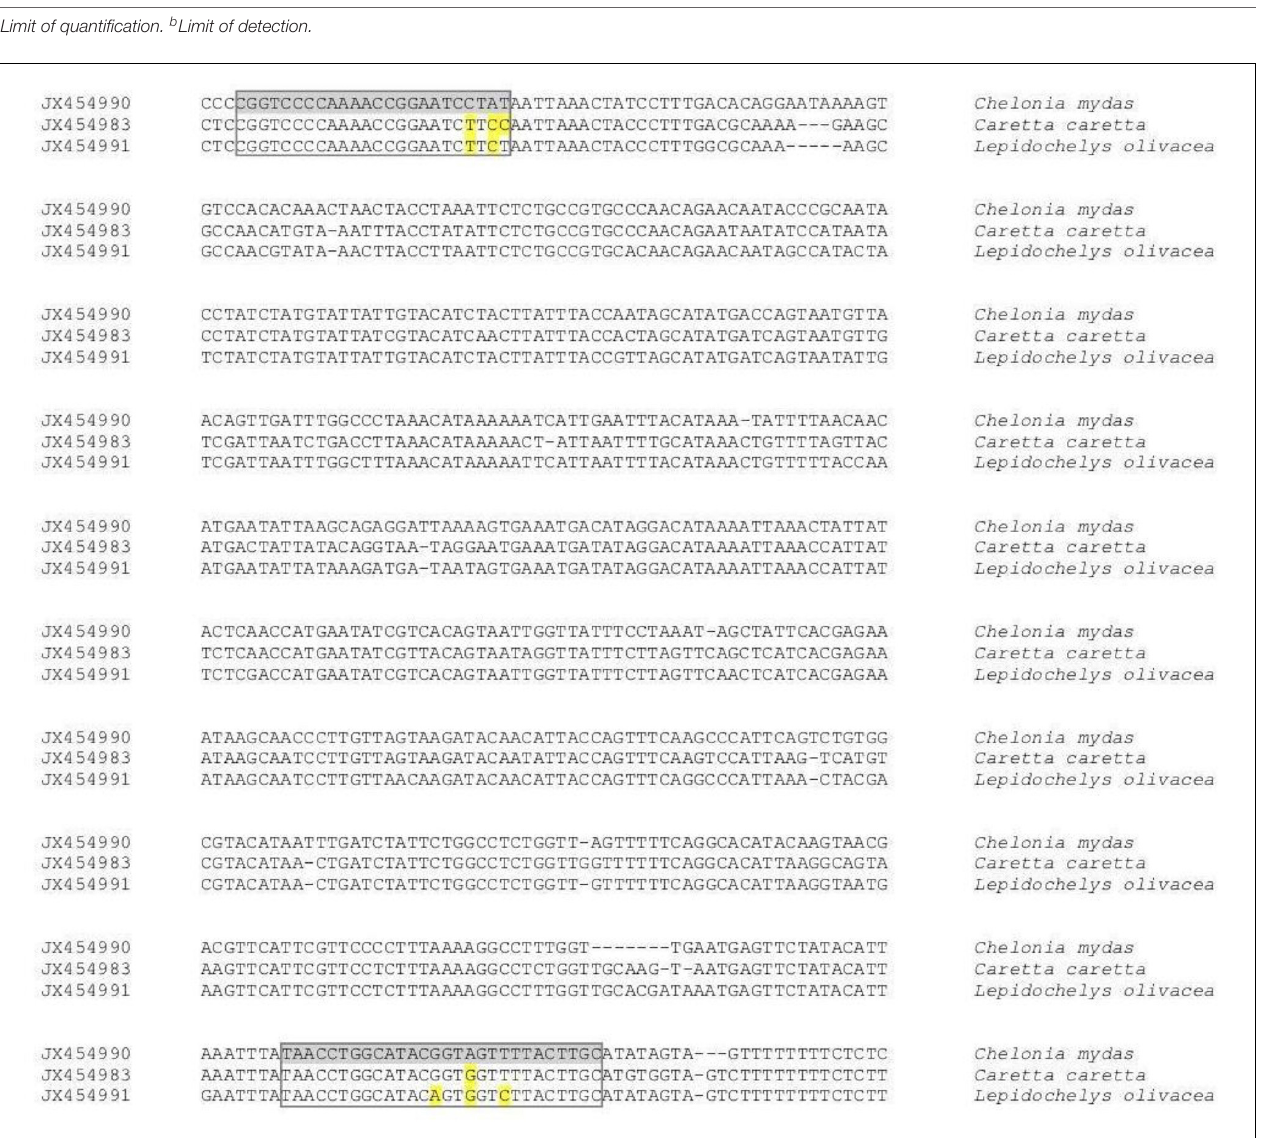
FIGURE 2 | The Chelonia mydas D-loop target region for the primer pair LTCM2/HDCM2. Forward and reverse primers for LTCM2/HDCM2 are highlighted in grey on a representative D-loop region for Chelonia mydas . In addition, representative D-loop target regions for other sea turtle species with mismatches on either the forward or reverse primers produced by ecoPCR are given. Highlighted nucleotides represent positions where the sequence of any entry differs from the primer (yellow highlight). Species shown: Caretta caretta and Lepidochelys olivacea .